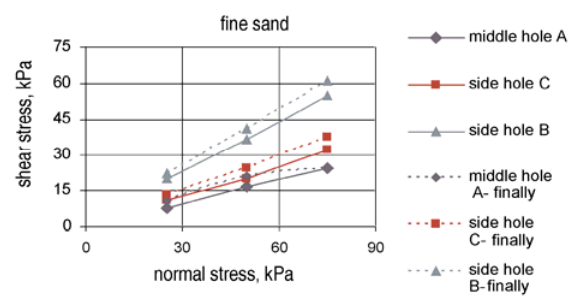
Fig 18 . Distribution of horizontal component of stress during test if there is slightly less sand in the cylinder than its